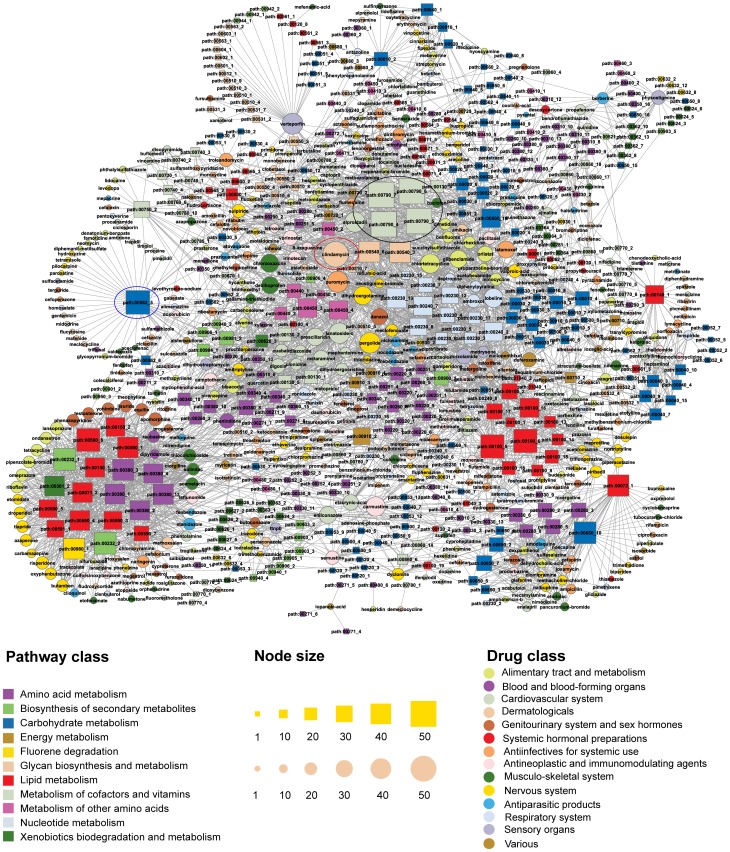
The DRSN network.The circles and rectangles in the network correspond to drugs and metabolic subpathways, respectively. A drug and a metabolic subpathway are connected by an edge if the corresponding drug-affected genes are statistically significantly enriched to the corresponding subpathway. Node size is proportional to the degree of the node. Nodes are colored according to 14 ATC and 11 KEGG pathway categories.